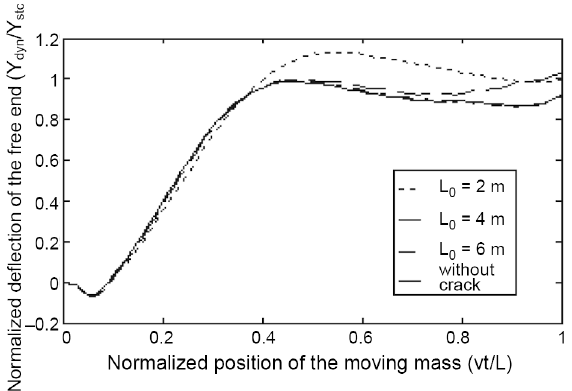
Fig. 3. Variation of the normalized deflection at the free end with respect to normalized position of moving mass for various values of crack position ( L 0 ). γ = 0.5, v = 10 m/s, M = 1000 kg